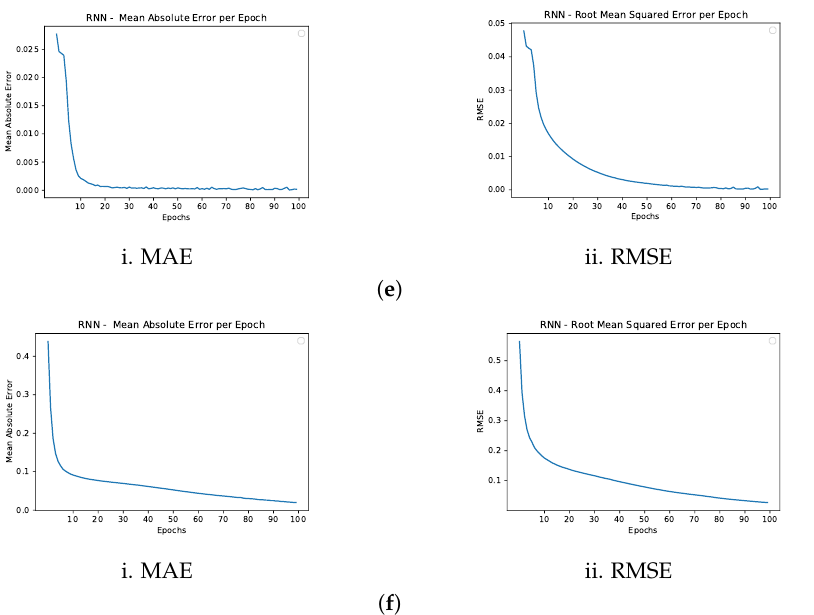
Figure 9. Metrics for the RNN Model. ( a ) Error Metrics for ANL-Intrepid-2009-1 Dataset. ( b ) Error Metrics for CEA-Curie-2011-2 Dataset. ( c ) Error Metrics for CIEMAT-Euler-2008-1 Dataset. ( d ) Error Metrics for KIT-FH2-2016-1 Dataset. ( e ) Error Metrics for METACENTRUM-2013-3 Dataset. ( f ) Error Metrics for UniLu-Gaia-2014-2 Dataset.